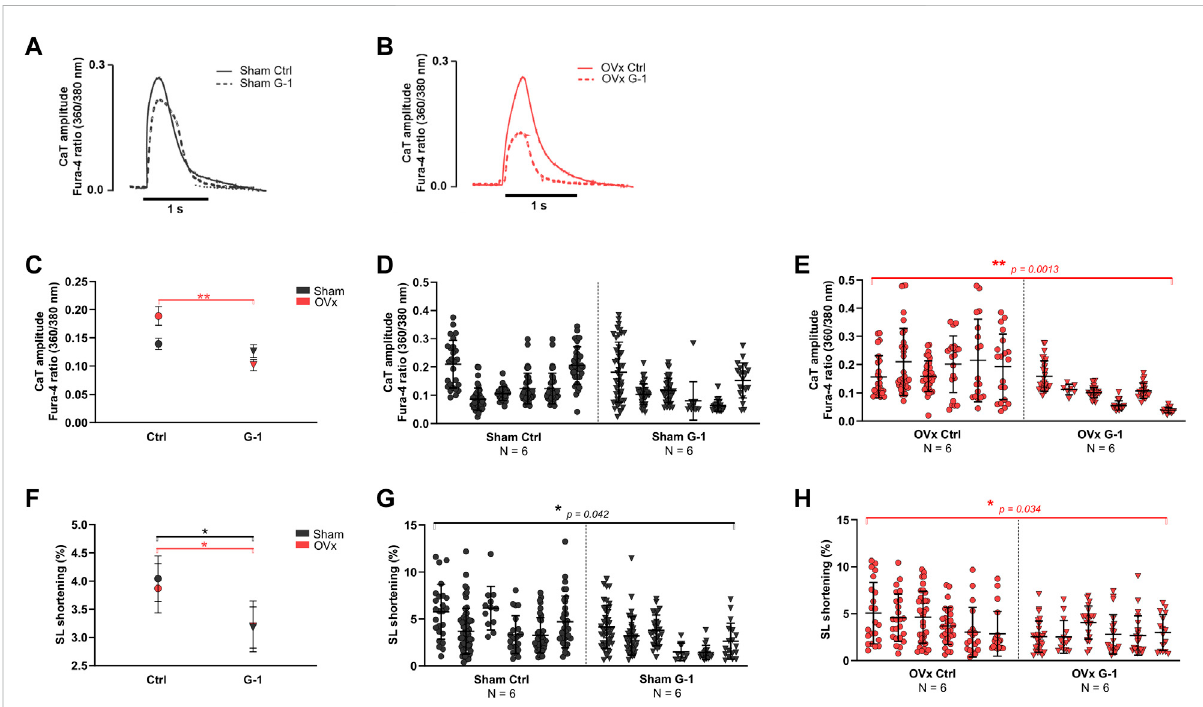
FIGURE 2 The effect of GPER activation on Ca 2+ transient (CaT) parameters and contractility in sham and OVx, measured using high-throughput CytoCypher system. (A) Representative CaTtracesofsham± G-1and (B) ofOVx ±G-1 inFura-4 loaded cardiomyocytes. (C) CaTamplitude was not changed in sham but reduced following GPER activation in OVx. Mean ± 95% CI. (D) Nested analyses of CaT amplitude changes following GPER activationinshamand (E) OVxcardiomyocytes.Mean±SD.** p < 0.01,valuesasindicated. (F)